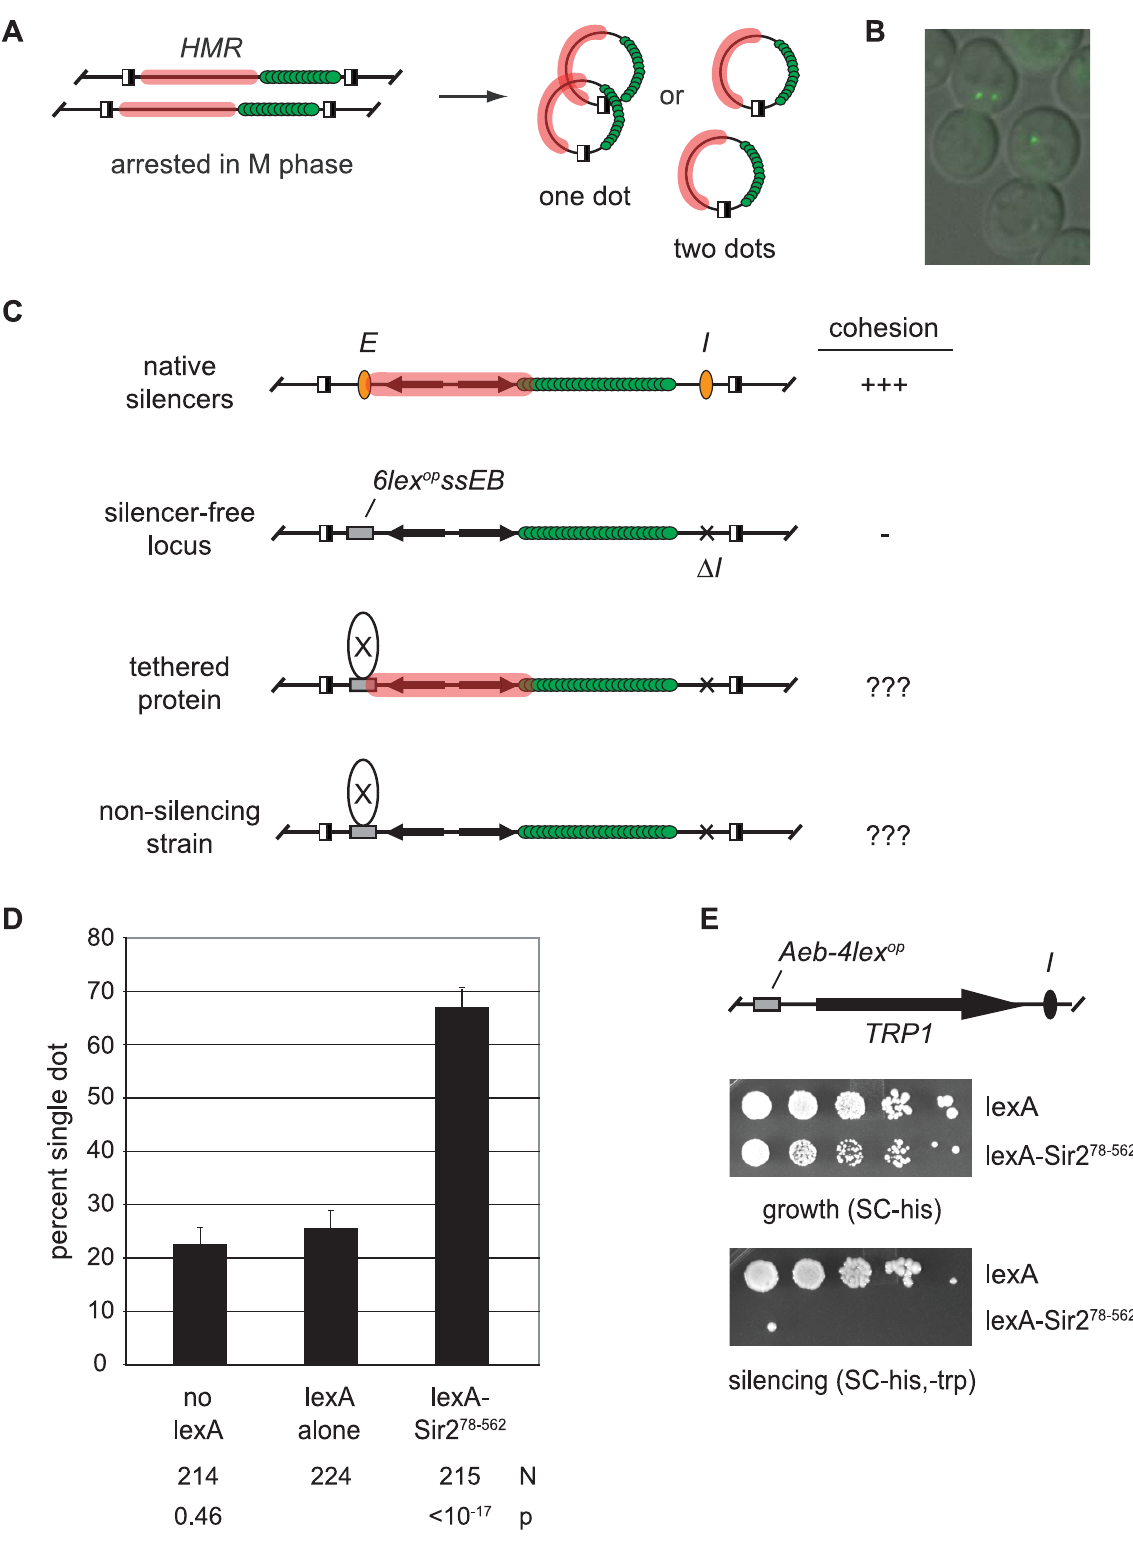
Figure 1. Tethered Sir2 mediates cohesion. A ) Evaluation of chromosomal cohesion by DNA circle formation. Site-specific recombination is initiated by galactose-induced expression of the R recombinase in cells arrested at M phase with microtubule inhibitors. Recombinase sites are depicted with half-filled boxes. Silent chromatin domains are highlighted with pink and lac-GFP is represented with green spheres. Cohesion of DNA circles yields a singe bright dot of fluorescence whereas lack of cohesion yields two dots. B ) Representative image of M phase-arrested cells with circularized HMR loci. C ) Protein-targeting assay for cohesion. Unexcised recombination cassettes are drawn for simplicity. The HMR silencers (orange